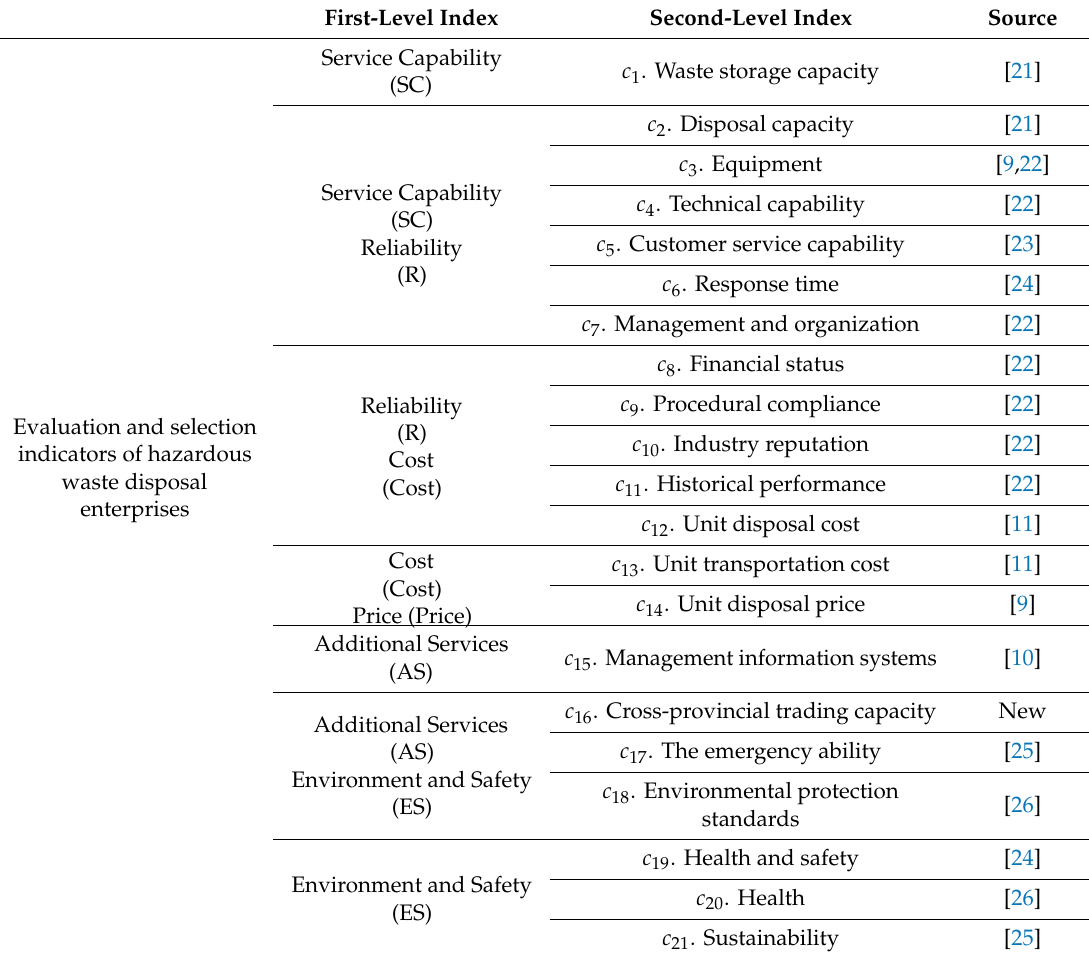
Table 1. Hazardous waste disposal enterprise selection evaluation index system.